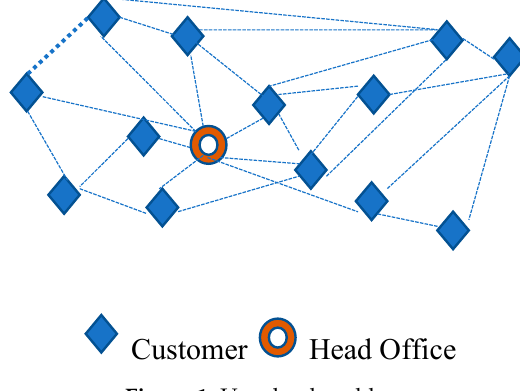
Figure 1. Unsolved problem.